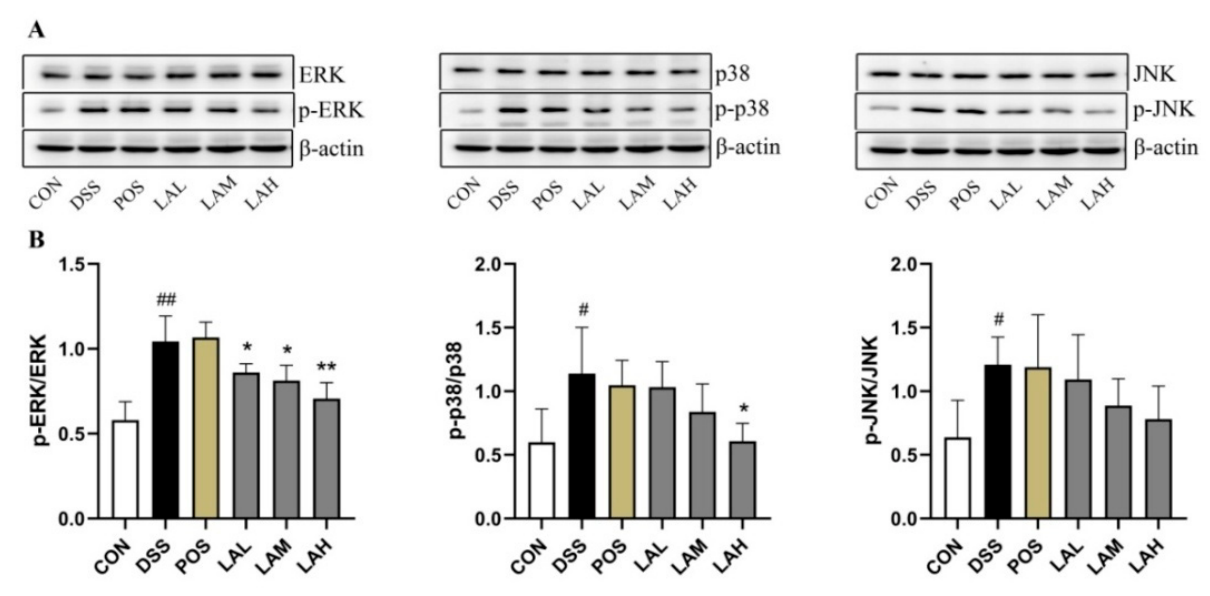
Figure 6. LA inhibited expression of MAPK pathway-related proteins. ( A ) Western blot (WB) images. ( B ) Relative levels of p-ERK/ERK, p-p38/p38, and p-JNK/JNK. Data are expressed as mean ± SD ( n = 3), # p < 0.05 and ## p < 0.01 vs. CON, * p < 0.05 and ** p < 0.01 vs. DSS.